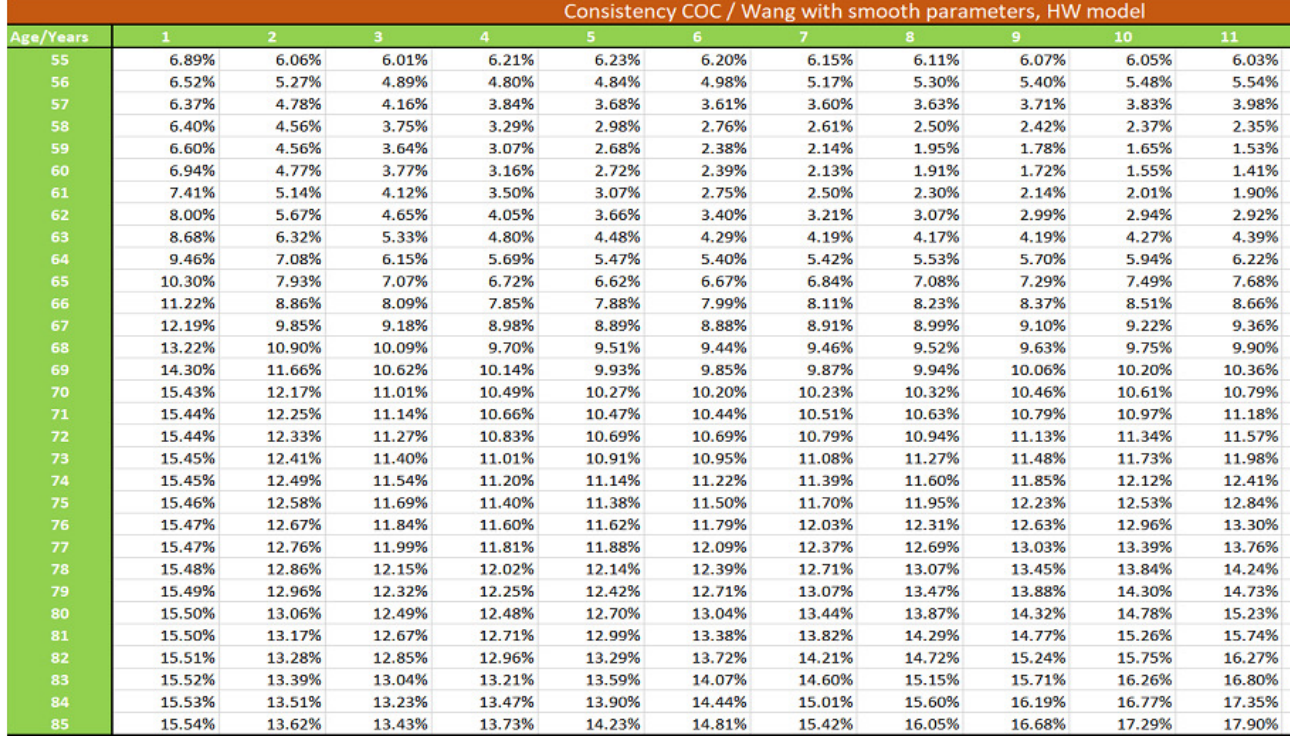
Figure A9. Consistency between Wang and Cost of Capital method with smooth parameters, HW